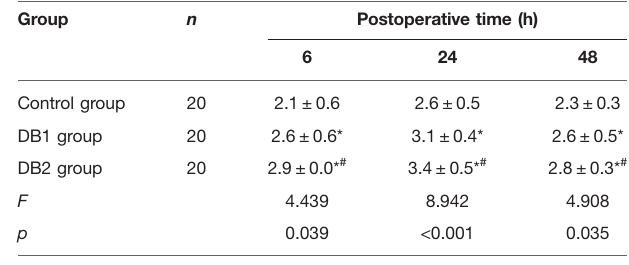
TABLE 7 | Comparison of Ramsay scores of puerperae at different times after surgery among three groups (mean±SD, score).